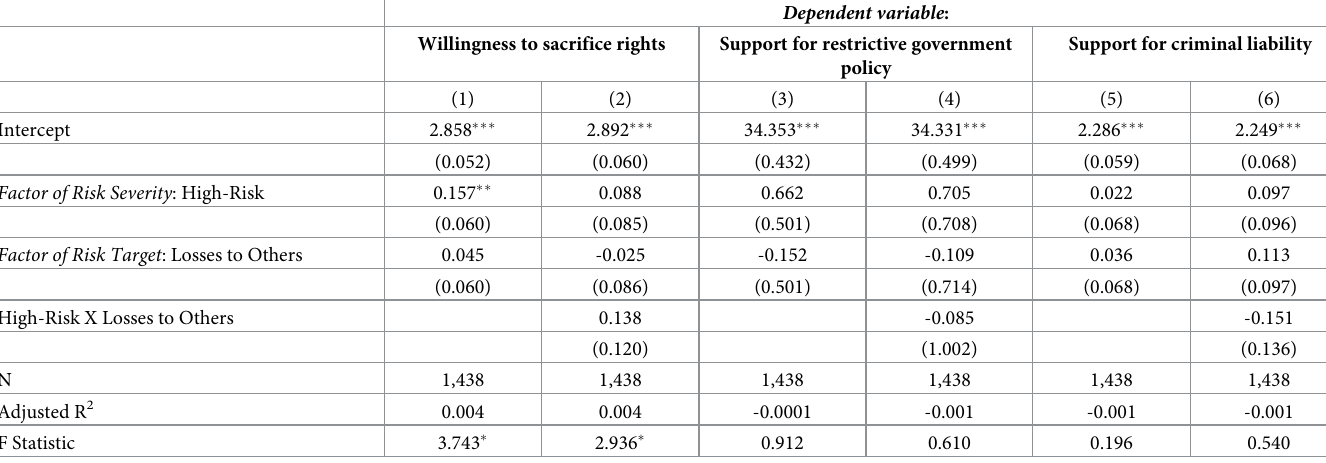
Table 8. OLS regression models estimates of main effects and interactions; pre-treatment covariates as controls are not